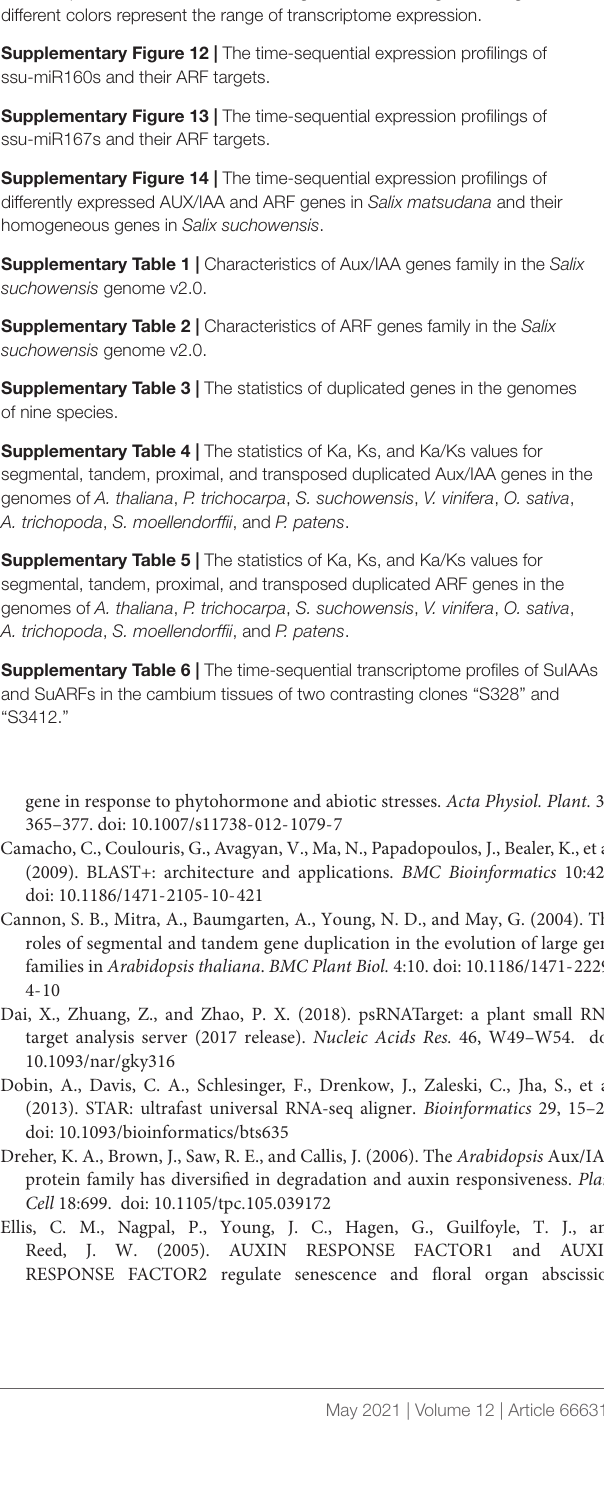
Supplementary Figure 4 | Phylogenetic relationships of ARF proteins in nine typical land plants. The neighbor-joining tree was constructed with three MpoARF, 15 PpaARF, seven SmoARF, 15 AtrARF, 25 OsaARF, 21 VviARF, 37 PtrARF, 34 SuARF, and 23 AthARF proteins. The colored solid circles indicate duplicated genes in different species, and the colored rings indicate non-duplicated genes in different species. The colored dashed links represent paralog duplicated pairs.